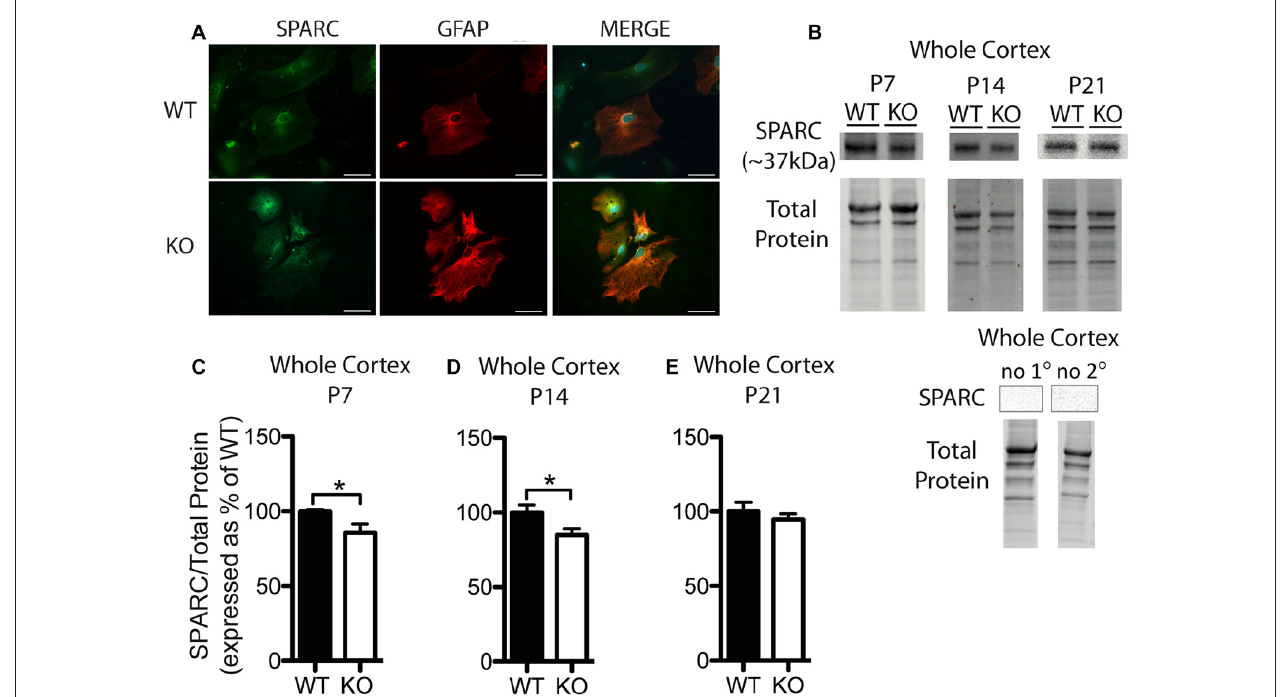
FIGURE 3 | SPARC expression is altered at postnatal day (P) 7 and P14 in the cortex of Fmr1 KO mice. (A) Cultured cortical astrocytes co-labeled with anti-GFAP (red) and anti-SPARC (green) after 2 days in vitro . Nuclei were stained with 4 (cid:48) ,6-diamidino-2-phenylindole (blue). Images were obtained using a 40x objective with a Zeiss Axioimager M2. Scale bars = 50 µ m. (B) A representative western blot shows bands at ∼ 37 kDa corresponding to SPARC in cortical samples (30 µ g of protein per lane) from P7, P14 and P21 WT and Fmr1 KO mice, as well as the total protein within each lane. Negative controls that were run using P21 WT whole cortical tissue with either no primary antibody or no secondary antibody are shown. (C–E) SPARC expression in the cortex of WT (black, n = 8) and Fmr1 KO (white, n = 8) mice at P7, P14 and P21, respectively. Bands representing SPARC were normalized to total protein within the same lane on the membrane and across gel controls, then expressed as a percent of the average level of SPARC in the WT group. Statistical differences were denoted with a single asterisk, P < 0.05.